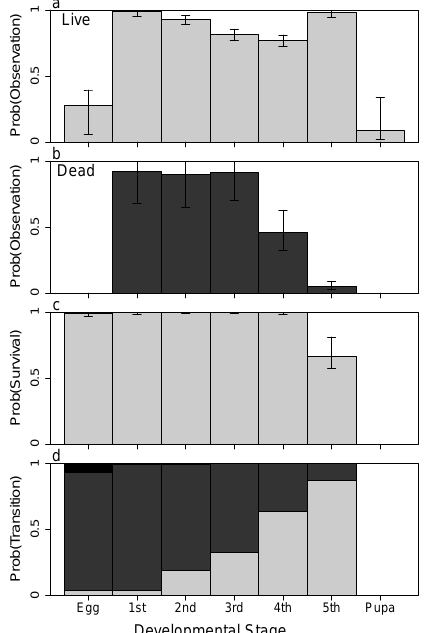
Figure 3. Stage-specific mean probabilities of ( a ) detection for live (light bars) and ( b ) dead (dark) individuals; ( c ) survival; and ( d ) transitioning from each stage i to either i (light), i + 1 (medium), or i + 2 (dark) during a 3-day interval for A. aidea , independent of survival. Error bars indicate the 95% credible